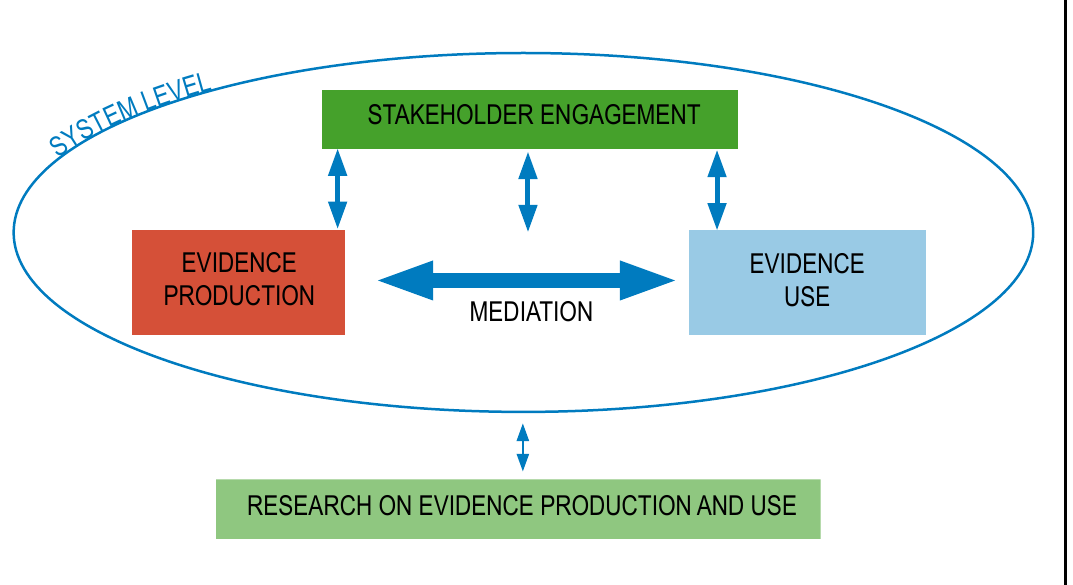
USESTAKEHOLDER ENGAGEMENT